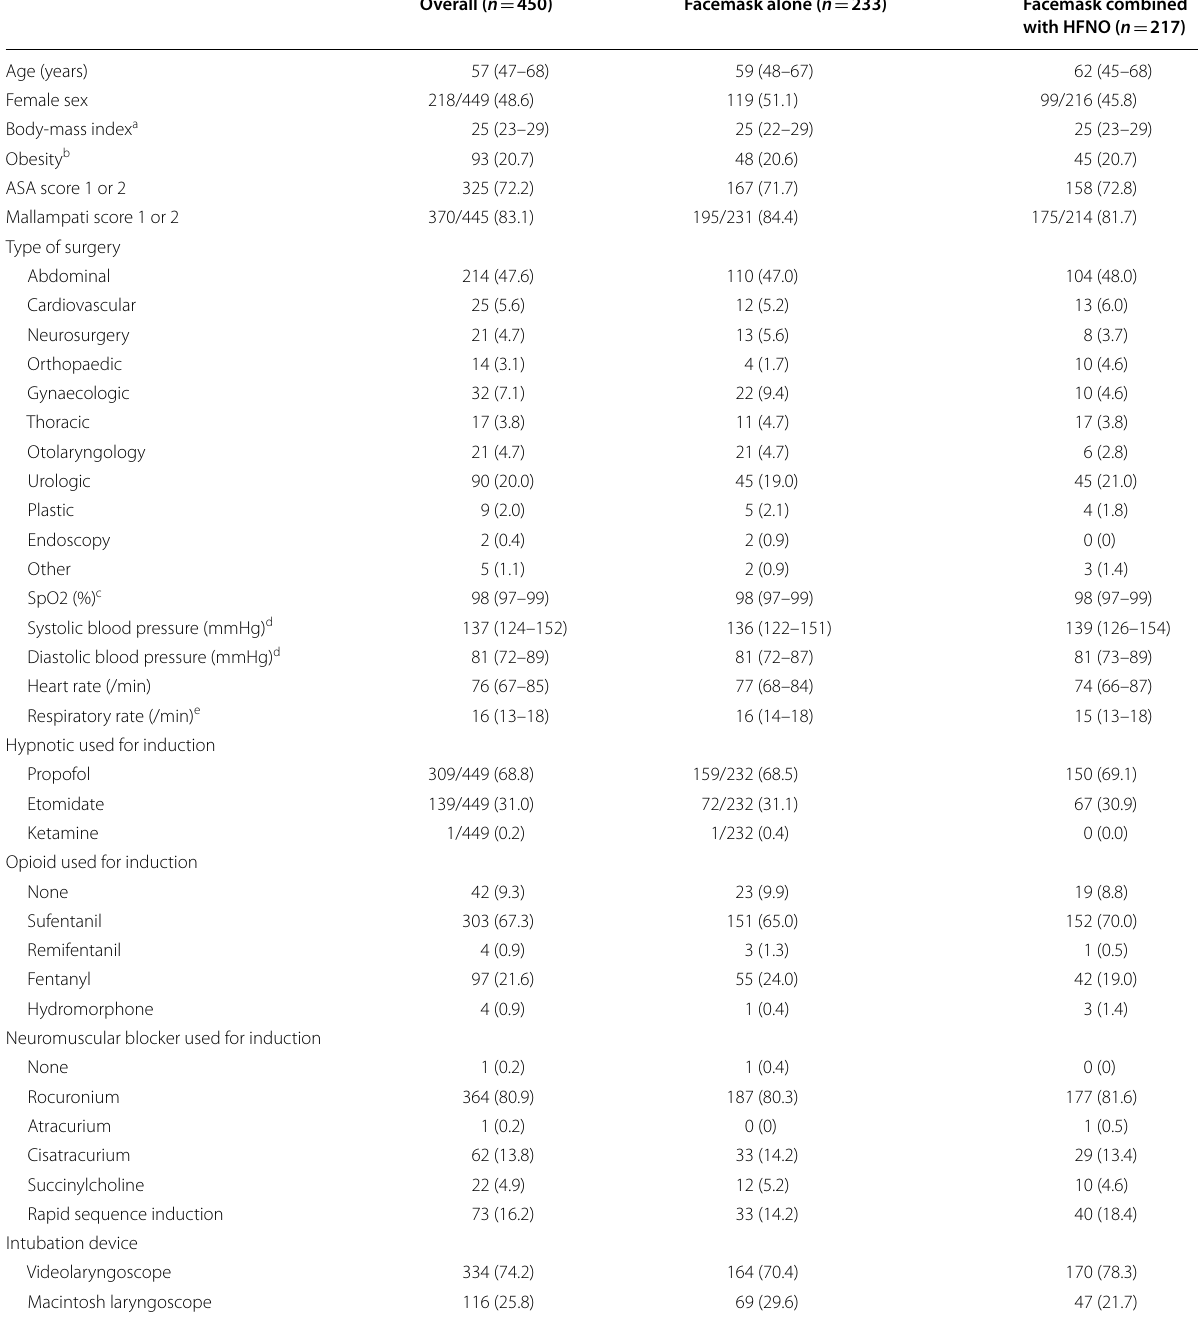
Table 1 Baseline characteristics of the overall